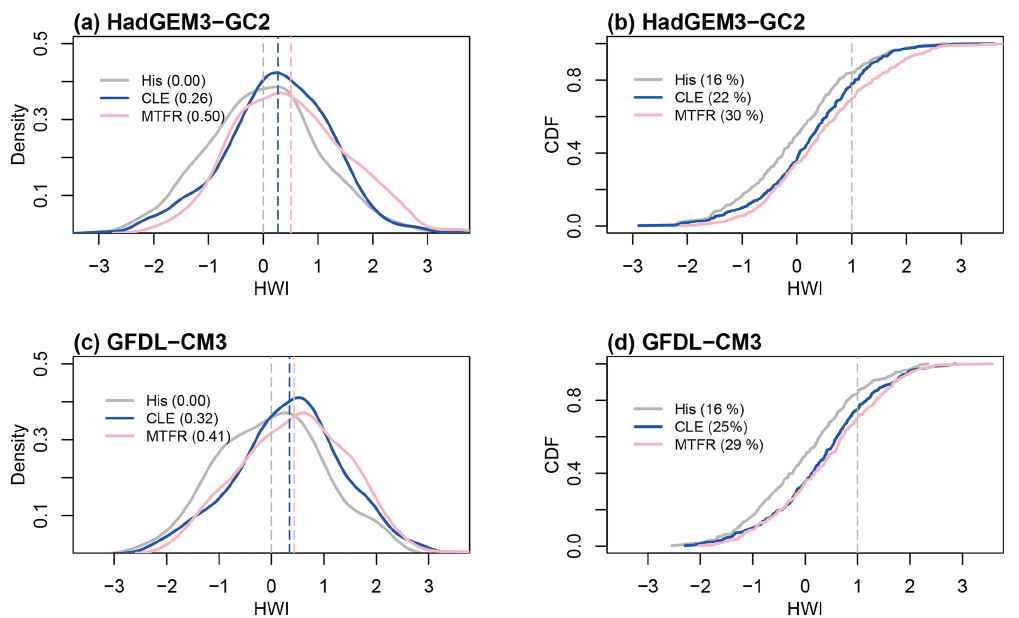
Figure 3. (a) Probability density function (PDF) via a non-parametric density estimation, kernel density estimation and (b) cumulative distribution function (CDF) distributions of HWI in winters of His (1984–2013, grey), CLE (2015–2049, blue) and MTFR (2015–2049, pink) simulated by HadGEM3-GC2. Panels (c–d) show results for GFDL-CM3. The numbers in (a) and (c) are the climate mean of HWI, and in (b) and (d) they are the frequency of month with HWI ≥ 1,